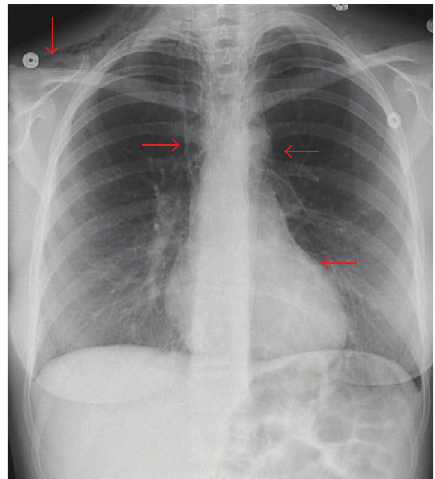
Figure 1: The chest X-ray demonstrates extensive subcutaneous emphysema and pneumopericardium (red